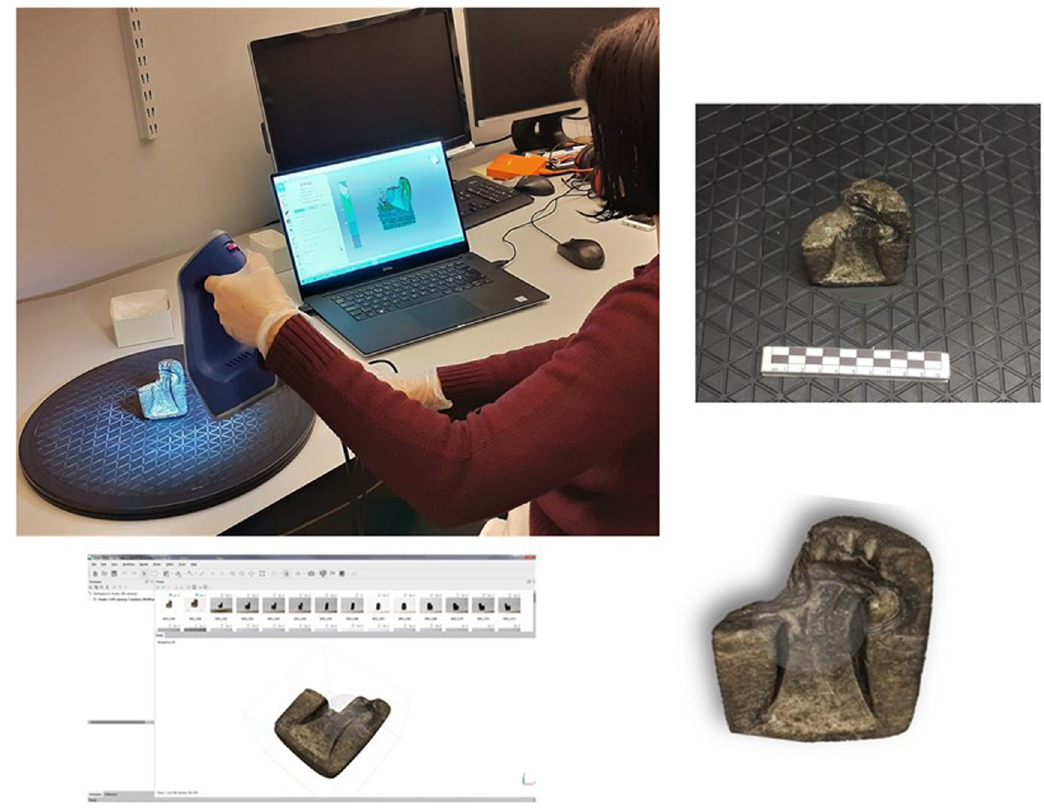
Figure 1: The acquisition of a Bronze Age mold using Artec Spider